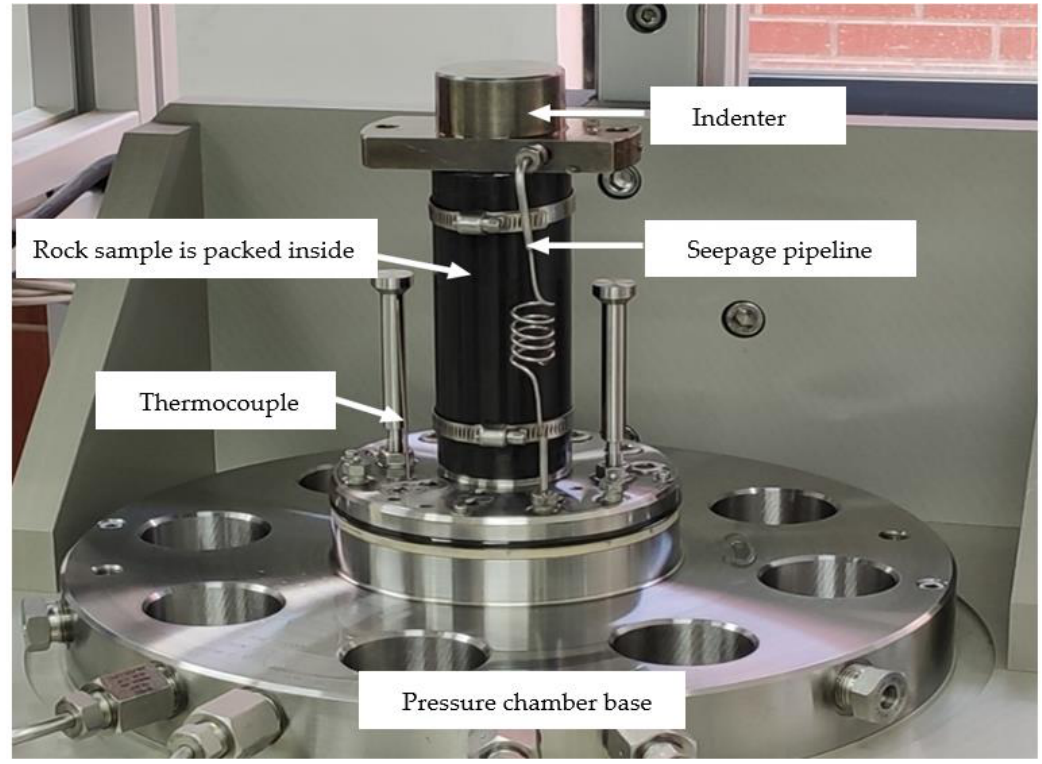
Figure 7. The package of rock sample and the sensor layout.